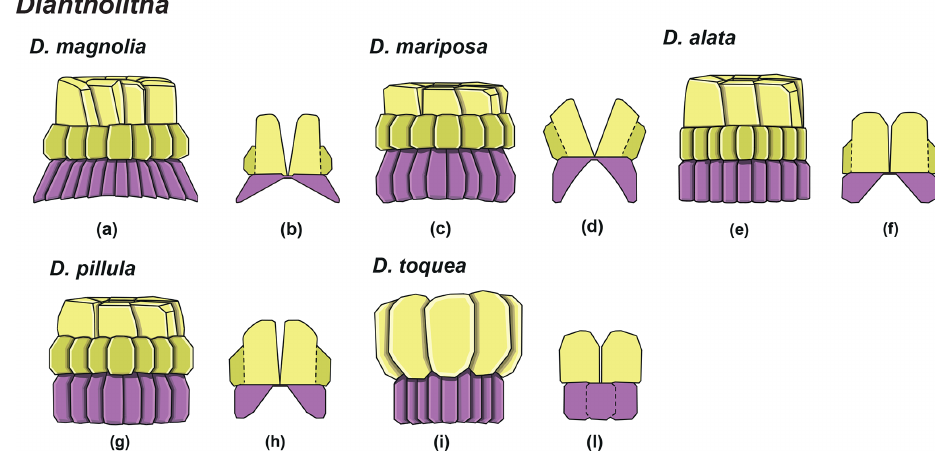
Figure 10. Overview of Diantholitha . (a) Schematic drawing of D. magnolia under SEM showing the position of the column (purple) and biretta (yellow and light green). (b) Schematic cross section of D. magnolia . (c) Schematic drawing of D. mariposa . (d) Schematic cross section of D. mariposa . (e) Schematic drawing of D. alata . (f) Schematic cross section of D. alata. (g) Schematic drawing of D. pilula . (h) Schematic cross section of D. pilula . (i) Schematic drawing of D. toquea showing the characteristic monocyclic biretta. (l) Schematic cross section of D. toquea.